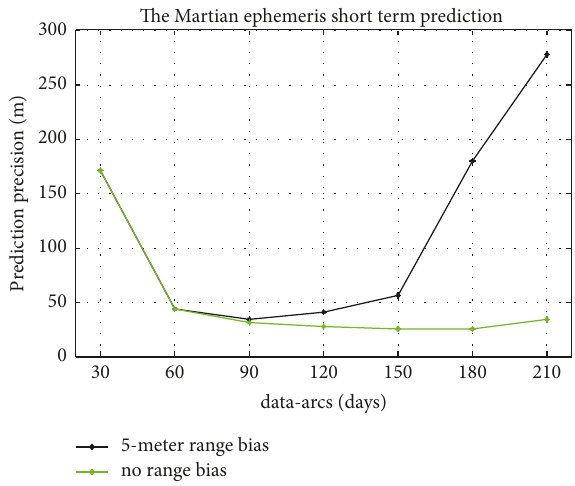
Figure 5: The Martian ephemeris short-term prediction using data whether containing range